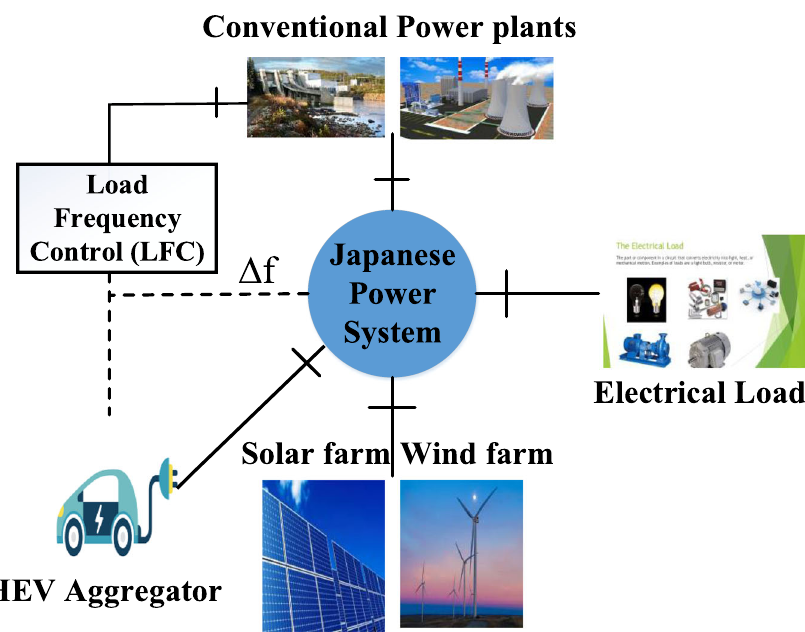
Fig. 1 Schematic model of the Japanese power system with a coordinated control JAYA optimized PID controller. A bi-directional vehicle-to- grid (V2G) power control PHEV is chosen for this study. In